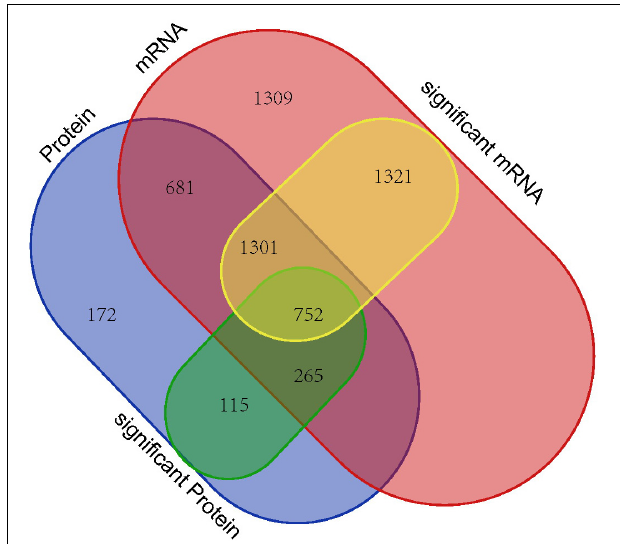
FIGURE 7 | Venn diagram showing all identified, as well as all significantly enriched, mRNAs and proteins and their